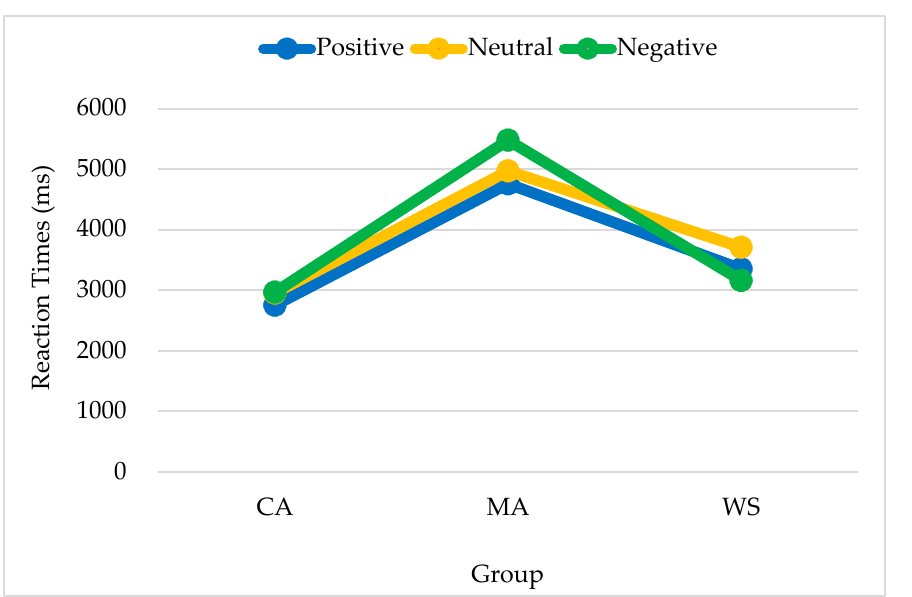
Figure 5. Reaction times of the responses to neutral primes by emotion target type and group. Note. CA, chronological age-matched controls; MA, mental age-matched controls; WS, participants with Williams syndrome.